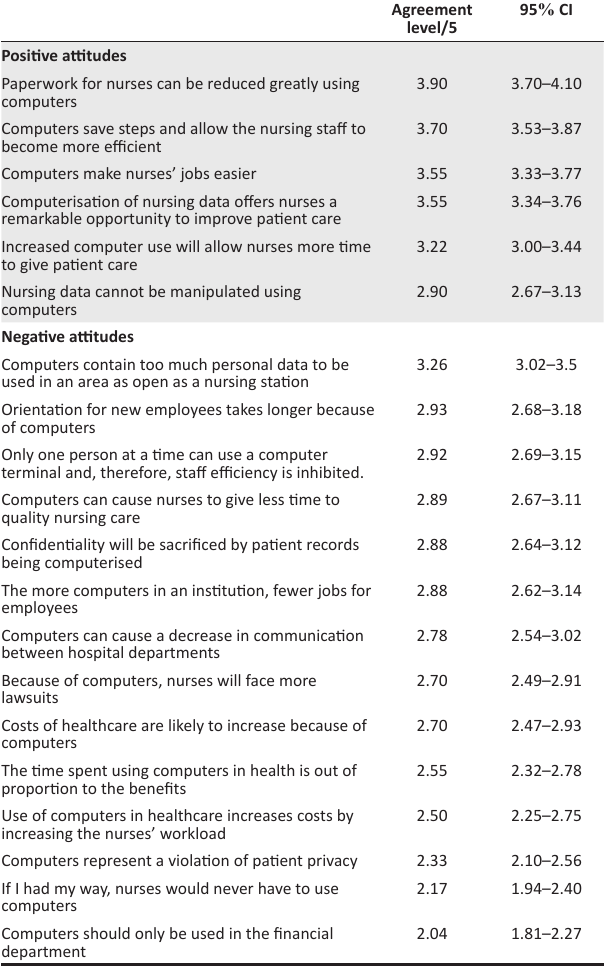
Agreement 95 % CI level/5